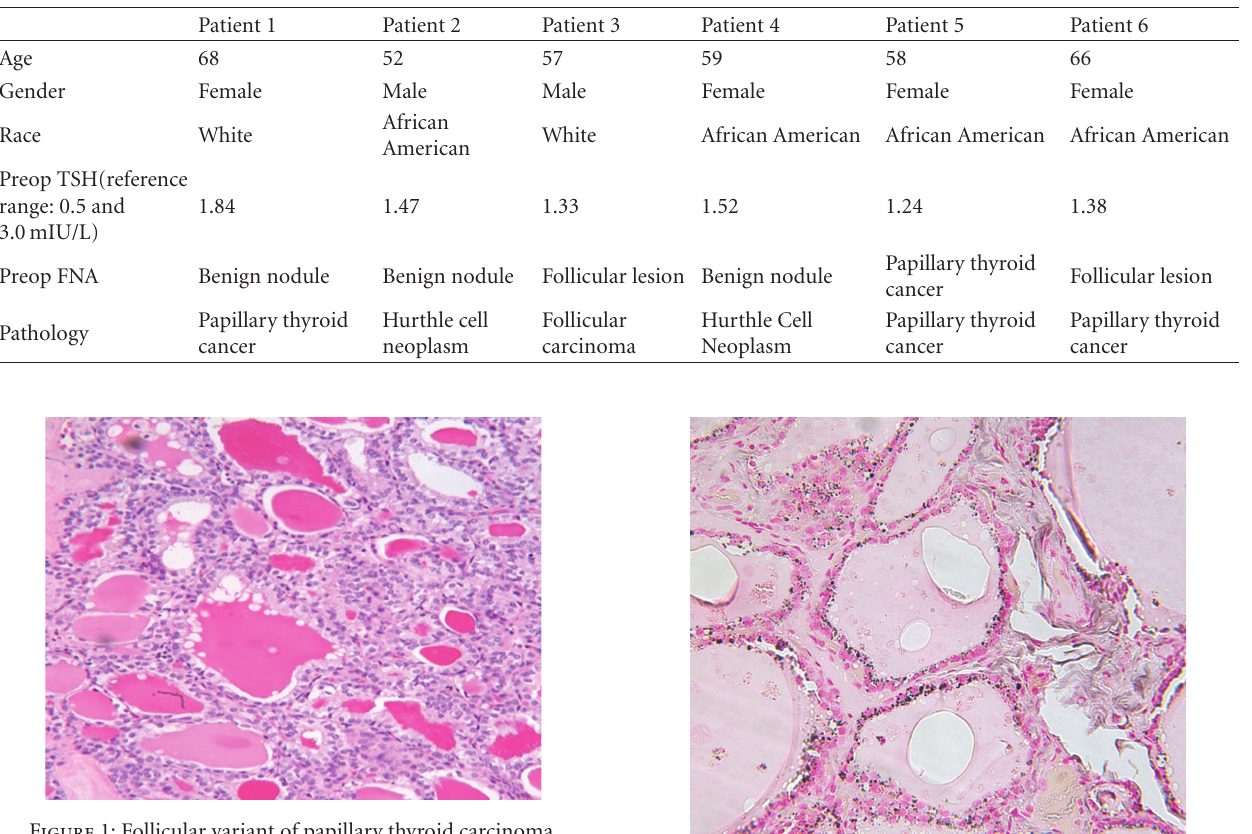
Table 1: Patients’ demographics and pathology information.